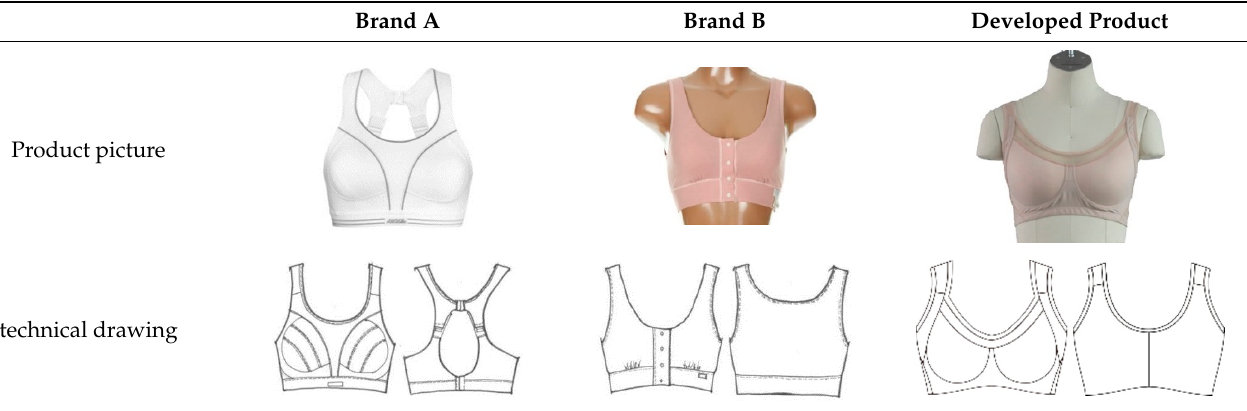
Table 3. Two bra tops and developed product selected for comparison.